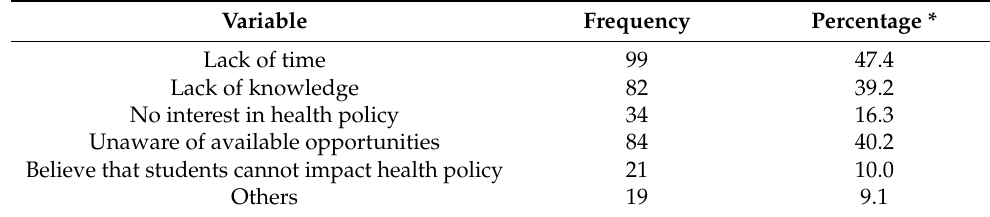
Table 3. The perceived factors preventing the students from participating in the health policy committee ( n = 209).